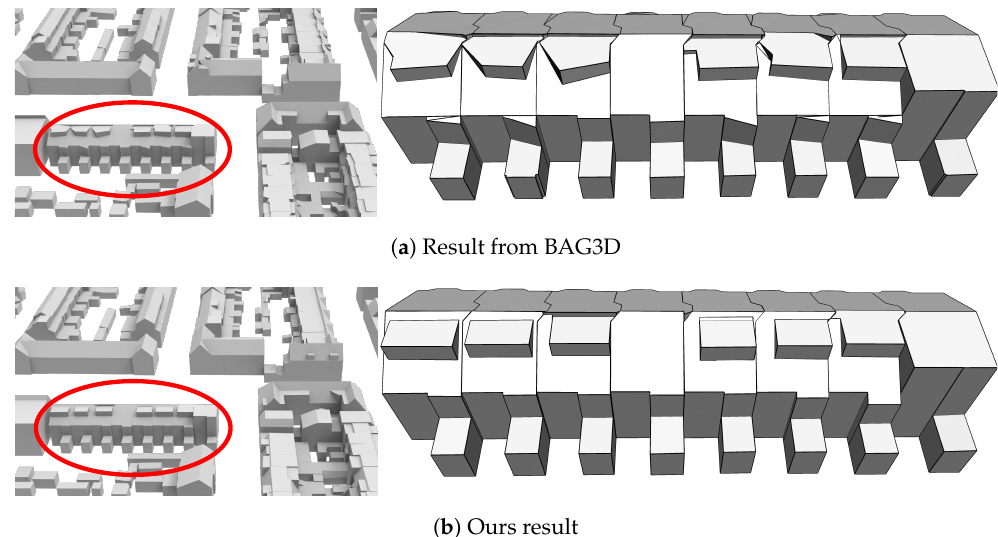
Figure 9. A visual comparison with BAG3D [55]. A building from Table 3 (b) is shown. Table 3. Quantitative comparison with the BAG3D [55] on four urban scenes (a)–(d). Both BAG3D and our method used the point clouds from the AHN3 dataset [21] as input. The bold font indicates smaller RMSE values.